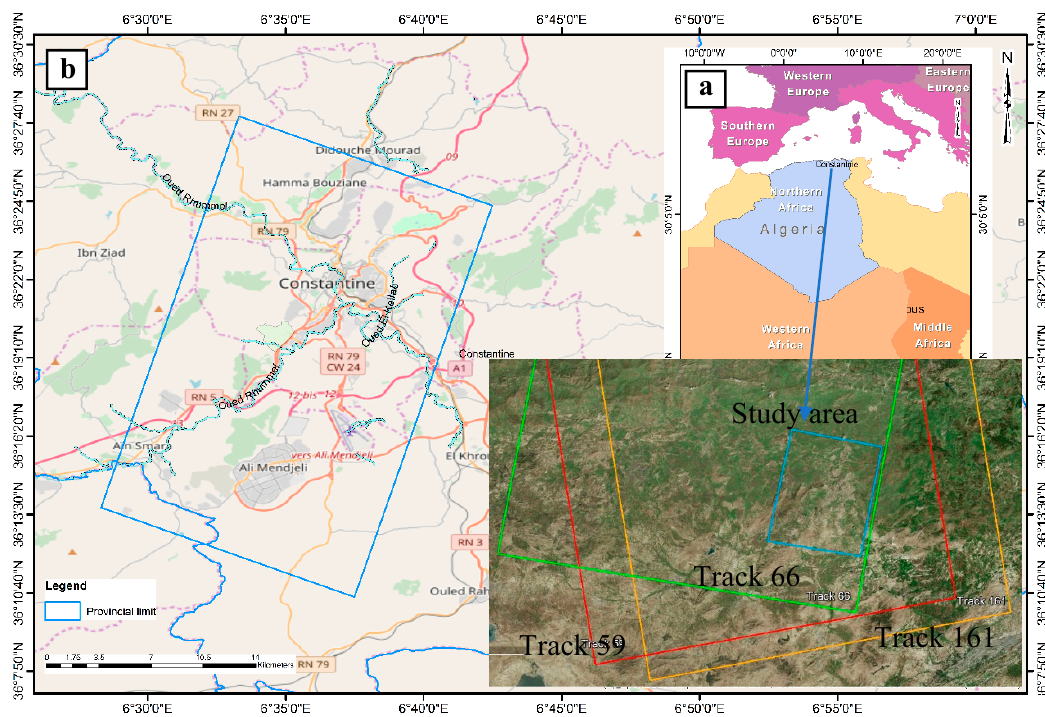
Figure 1. ( a ) Geographical location of the study area within northeast Algeria; ( b ) Provincial limit of the Constantine city and study area square.